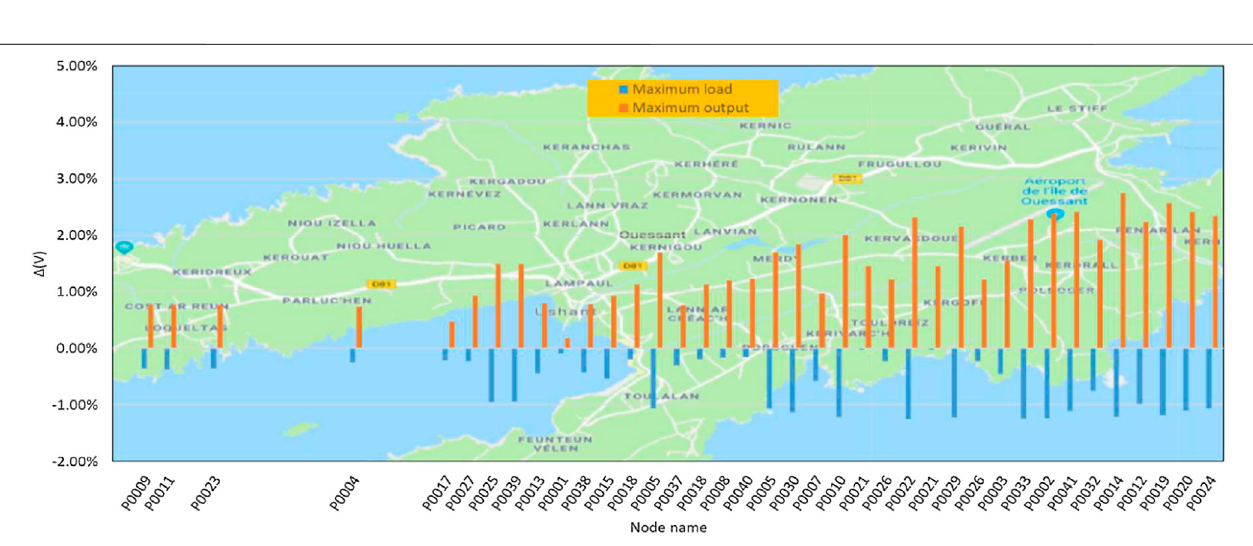
FIGURE 16 | Voltage drop at each load node under maximum load demand and maximum renewable energy generation power output (case 2).